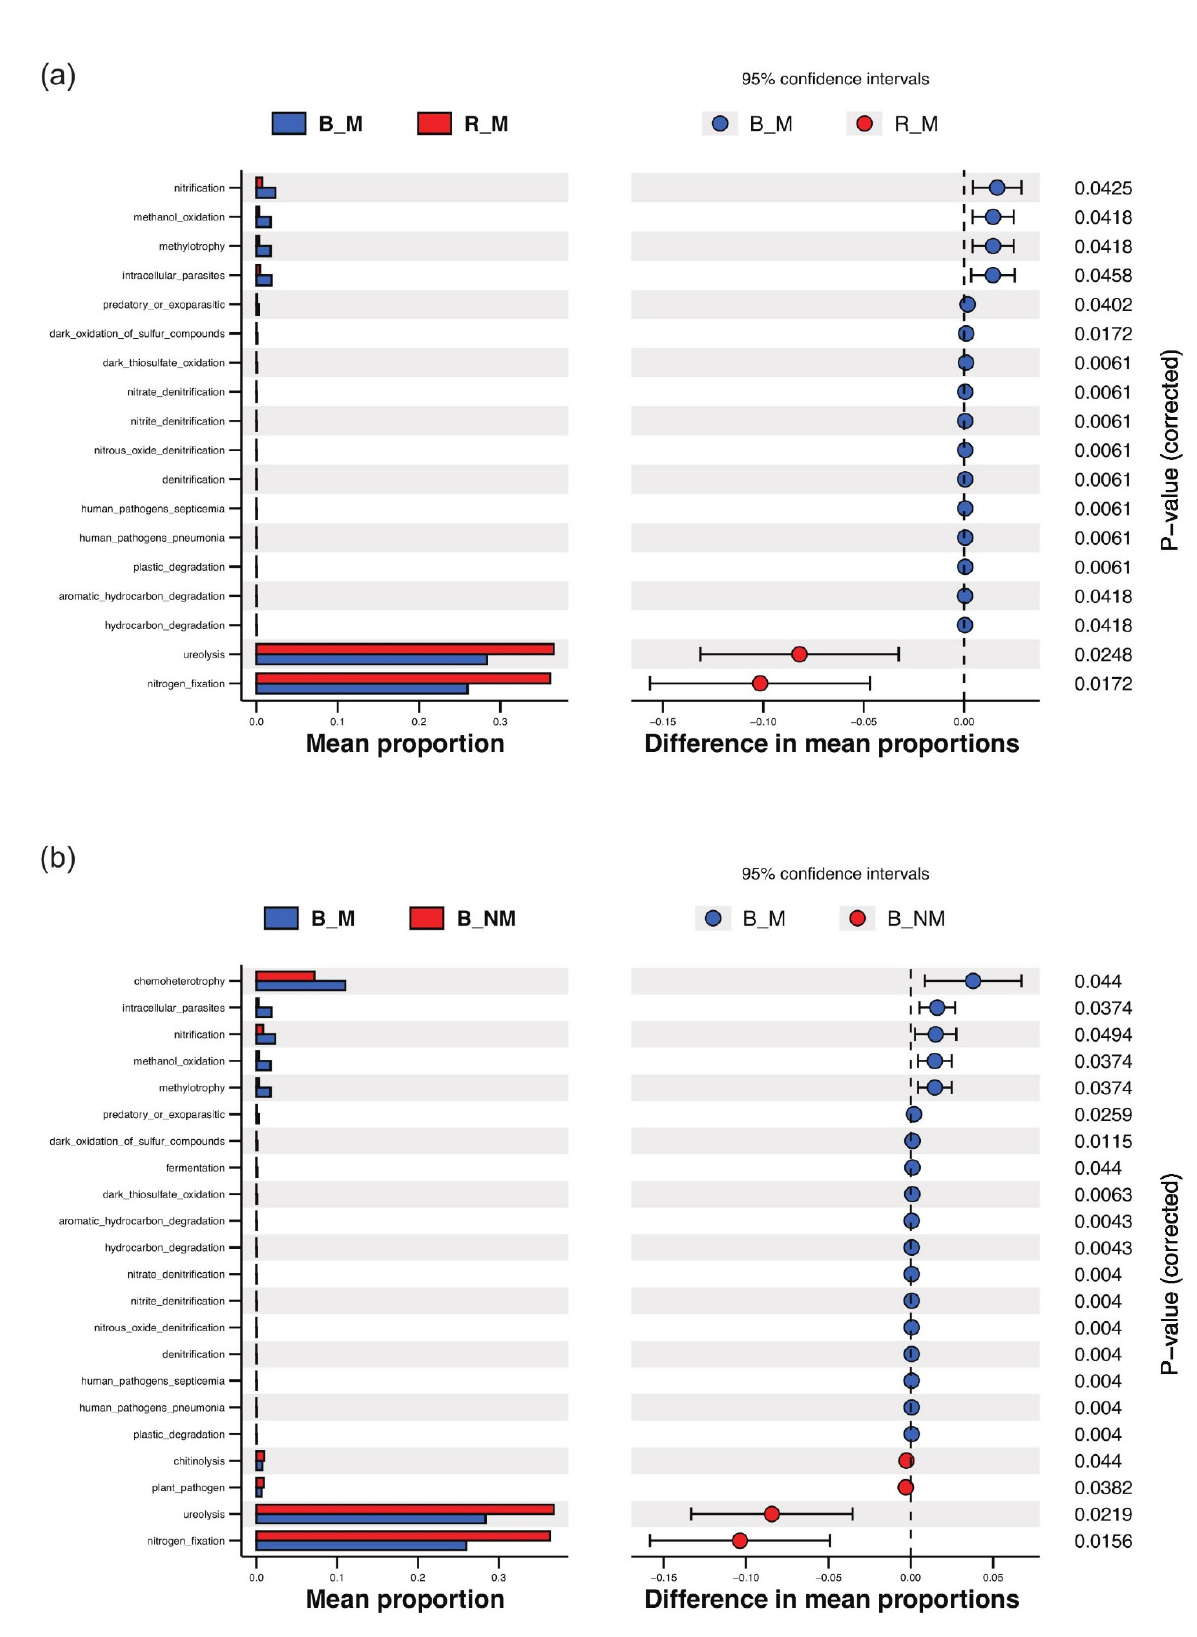
Figure 5. Functional predictions of bacterial communities between bulk and rhizosphere soils under different fertilization treatments. ( a ) Comparison between bulk and rhizosphere soils in BOF treatment; ( b ) comparison between BOF and NBOF in bulk soil